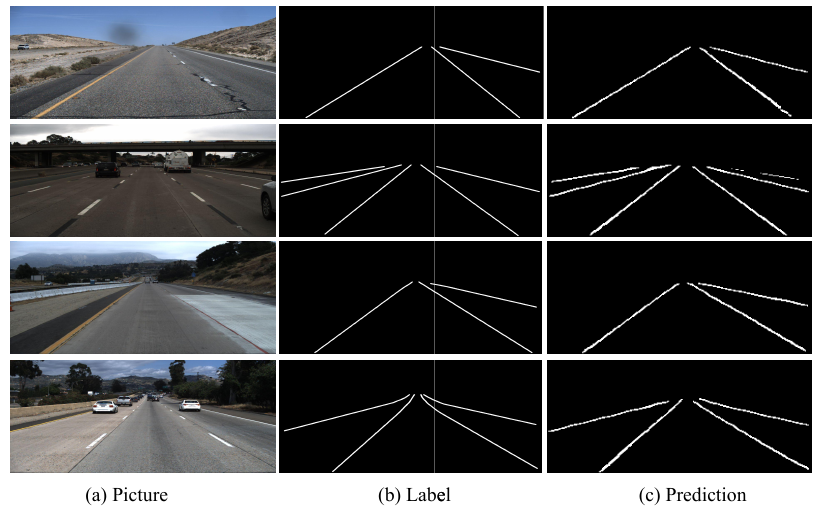
Figure 7. The results of the proposed network models on TuSimple.